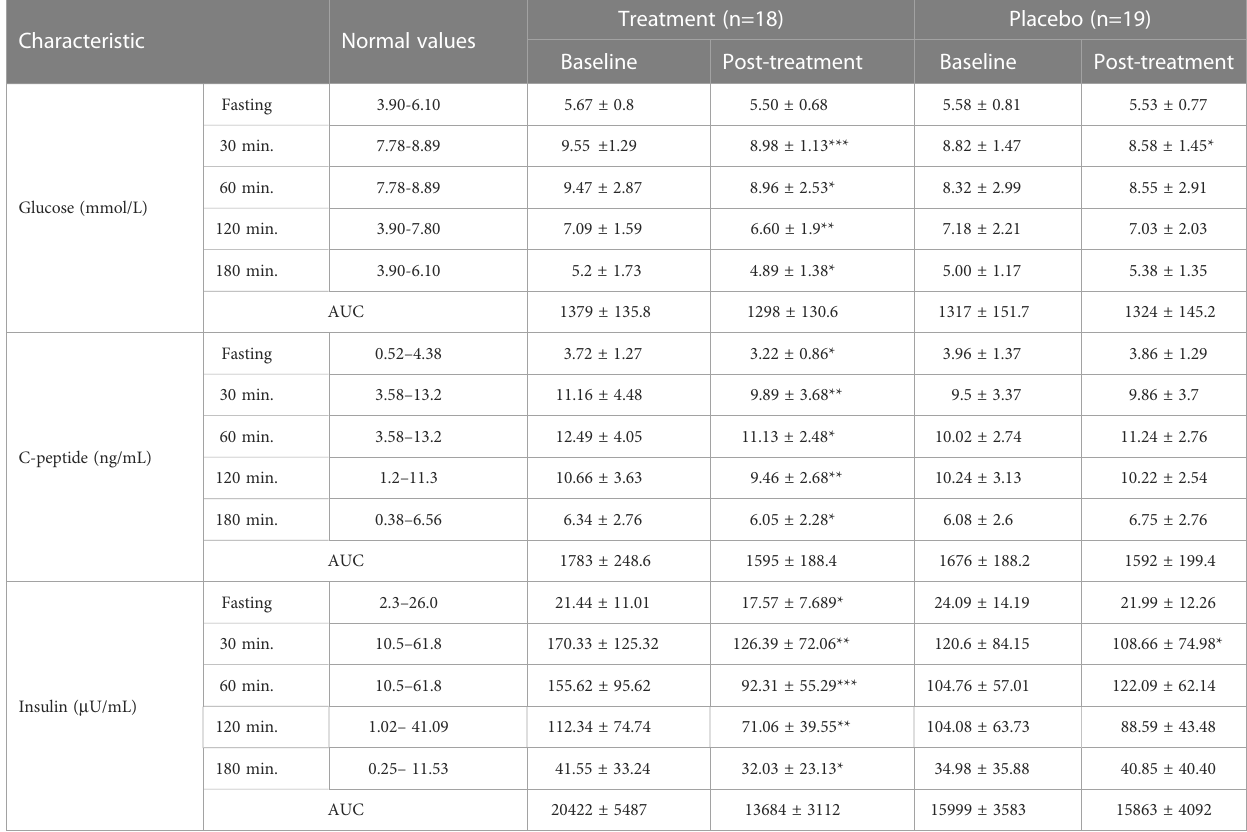
TABLE 2 Results of GGT, CRT and ICT in the two group before and after treatment.